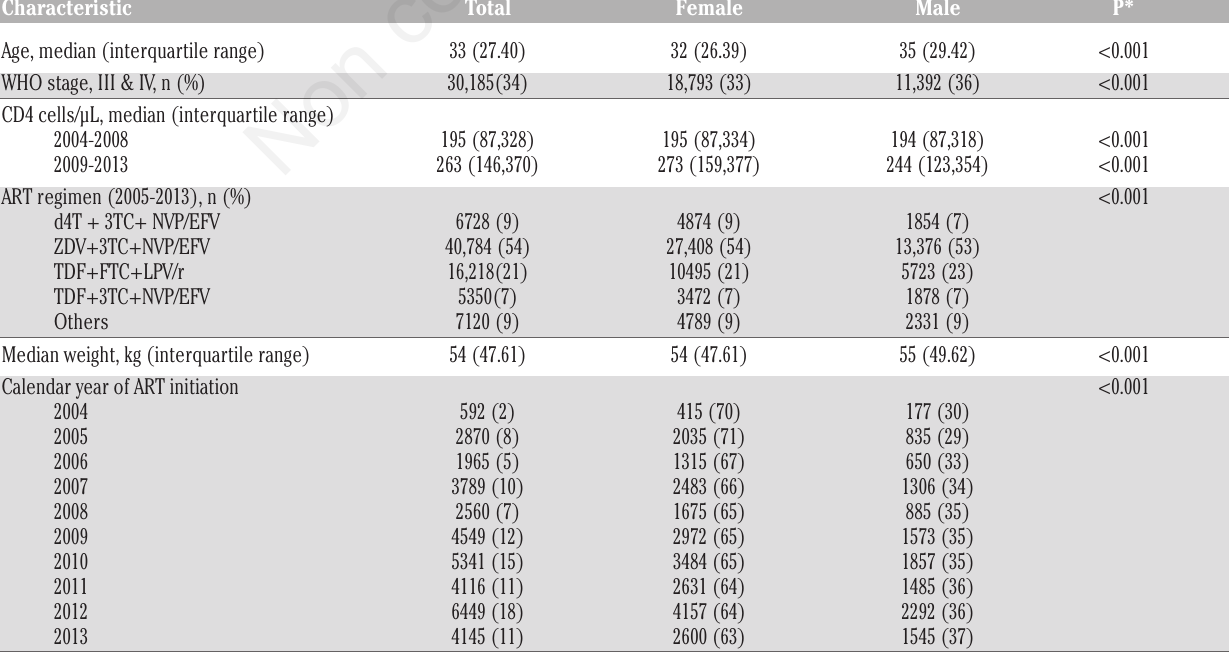
Table 3. Baseline characteristics of the study participants at commencement of highly active antiretroviral therapy (ART), total and gen- der specific (N=36,372).